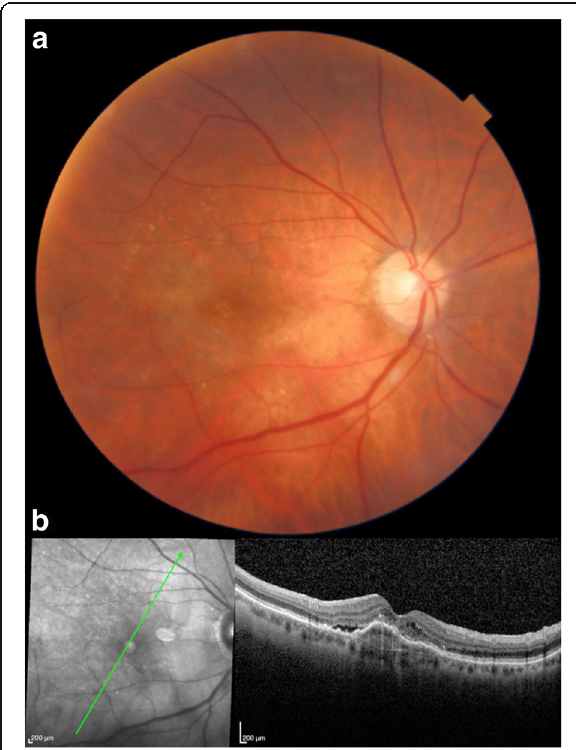
Fig. 2 Patient 1. a Color retinography showing drusen and b OCT showing fibrovascular pigment epithelium detachment with subretinal and intraretinal fluid